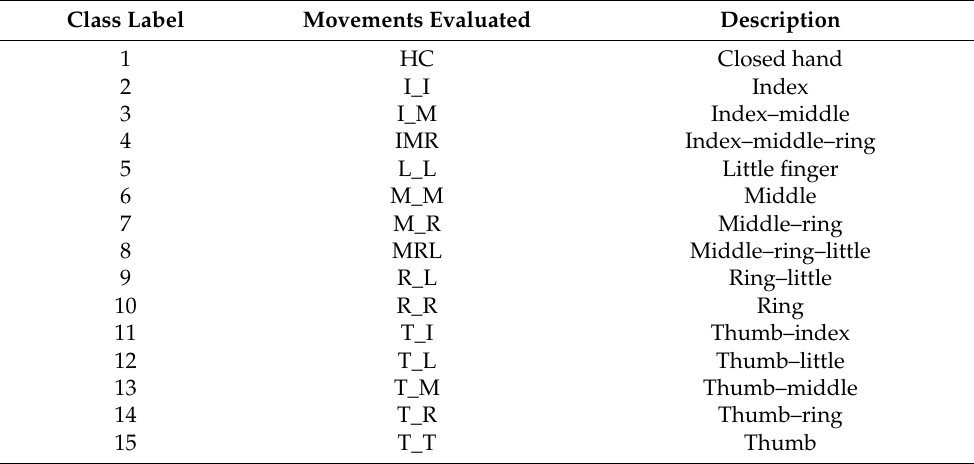
Table 1. Relationship of movement types of the database and their class labels assigned. Flexion of the fingers involved is